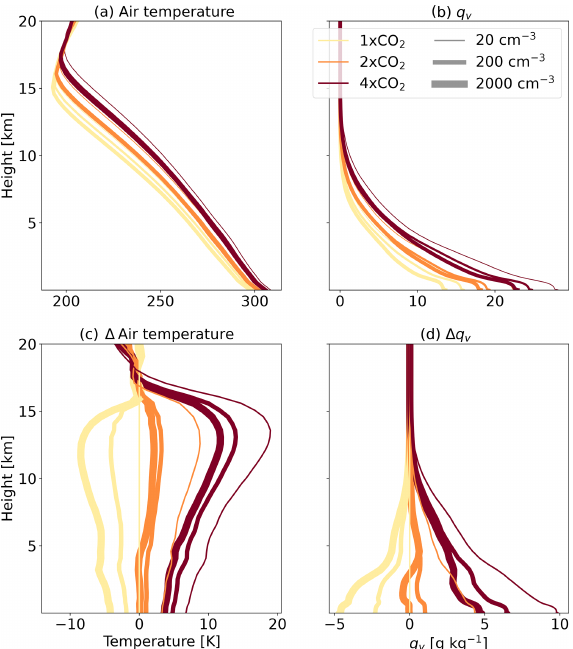
Figure 2. Time- and domain-mean vertical profiles of air temper- ature and water vapour mixing ratio ( q v ) in the different simula- tions (a, b) and how they differ from the simulation with the lowest N a and CO 2 concentrations (c, d)